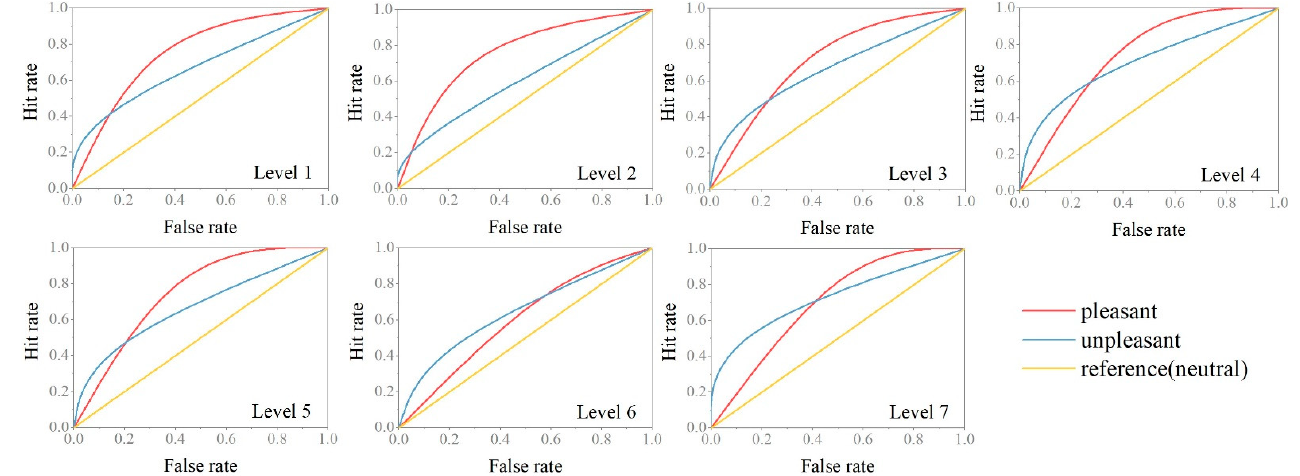
Figure 4. Receiver operating curve. ROC was used to evaluate the accuracy of a binary classifier. A false rate represents a false-positive rate, while a hit rate represents a true-positive rate.